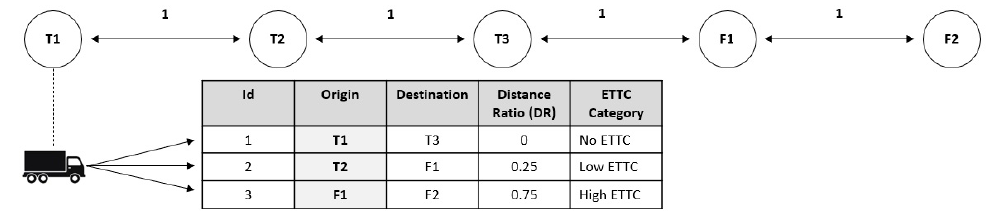
Figure 5. Example of distance ratio and ETTC category based on the distance ratio.